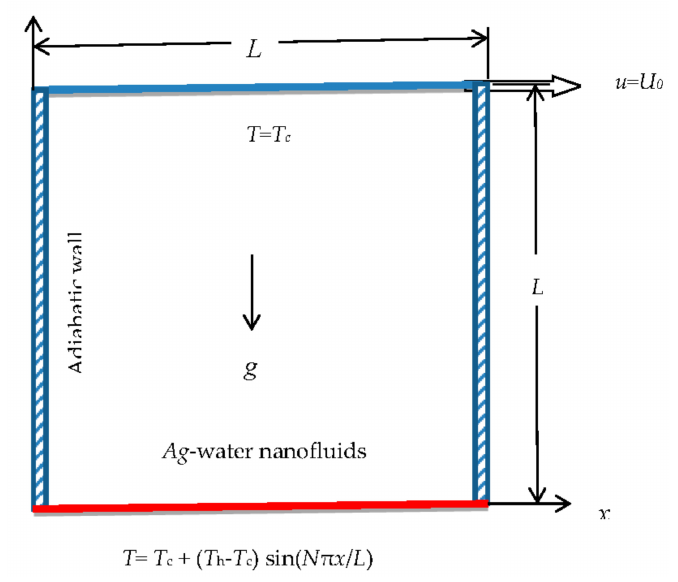
Figure 1. Schematic view of the cavity with the boundary conditions.